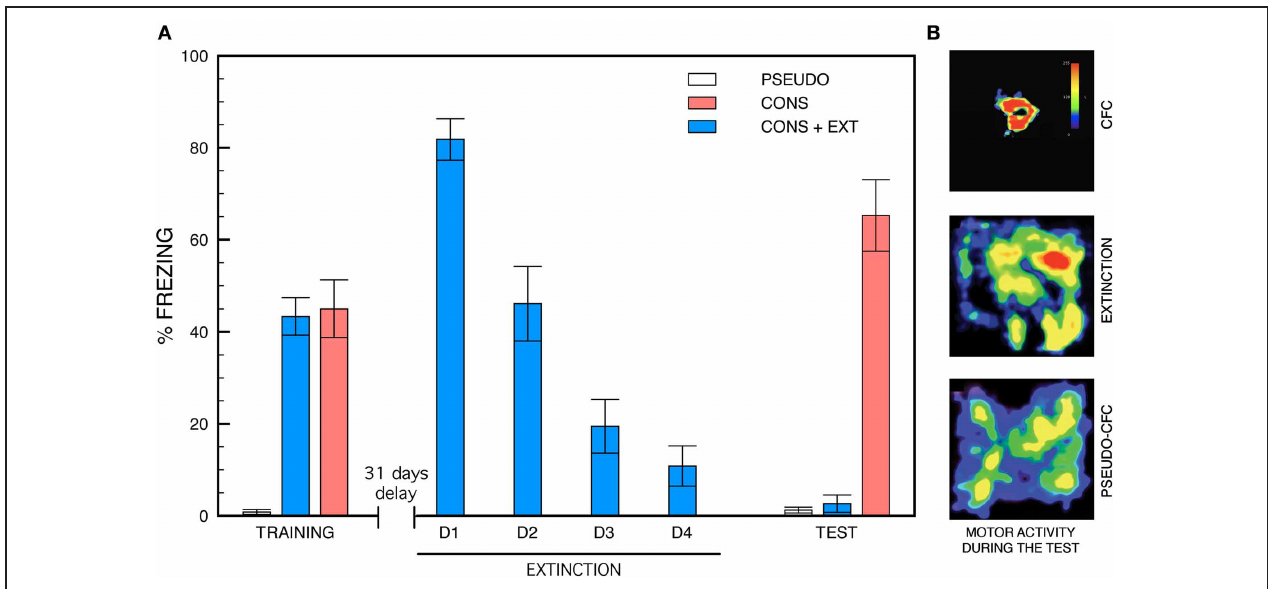
FIGURE 1 | Freezing behavior and motor activity patterns. (A) Freezing behavior during contextual fear conditioning, remote extinction and remote memory testing. During the conditioning, mice exposed to context-shock pairings (CONS and CONS + EXT) show robust freezing compared to non-shocked (PSEUDO) mice [group effect, ( F ( 2 , 30 ) = 28 . 24, P < 0 . 001); CONS or CONS + EXT vs. PSEUDO, P < 0 . 001 for each pair comparison). Remote fear extinction was generated by re-exposing half of the conditioned mice to the safe conditioning chamber from day 32 to day 35. These mice (CONS + EXT) exhibited a progressive decrease in their freezing response across re-exposure days [effect of days, ( F ( 3 , 40 ) = 29 . 37, P < 0 . 001)].